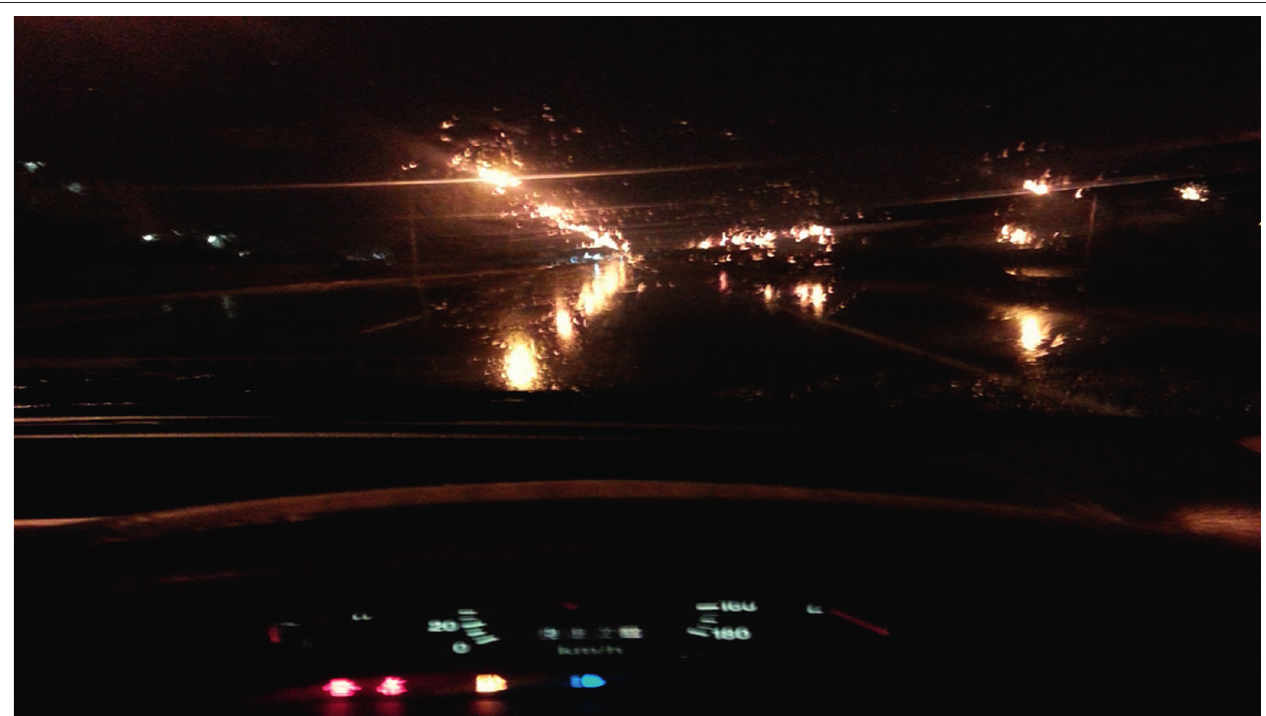
FIGURE 2: Sonwabo’s picture of poor visual conditions on the